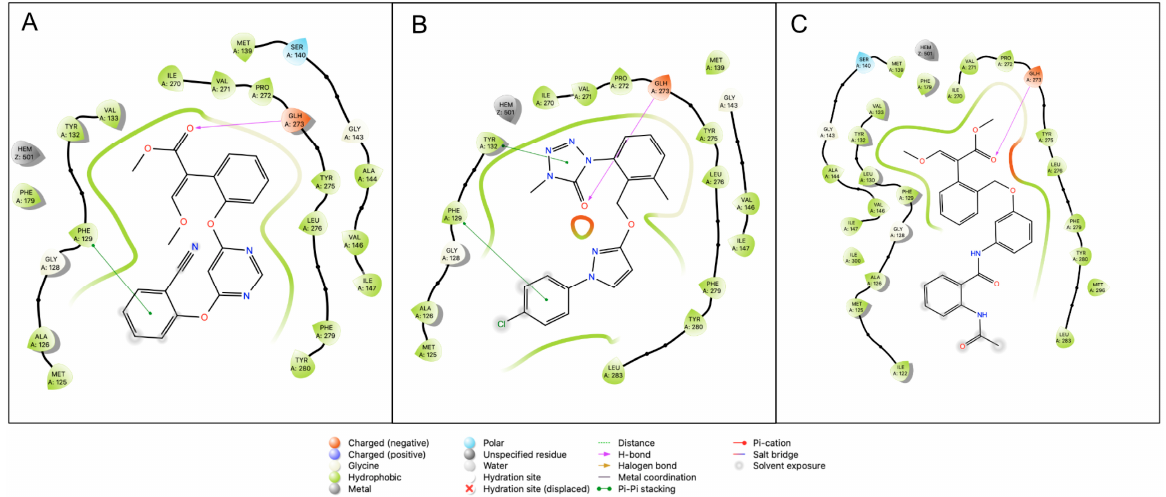
Figure 9. Ligand interaction diagram for ( A ) azoxystrobin, ( B ) metyltetraprole, and ( C ) compound 11b . H-bond between the carbonyl function of the ester group and Glu273 is pointed out by the purple arrow, and π - π stacking between the distal aromatic ring and Phe129 is pointed out by green